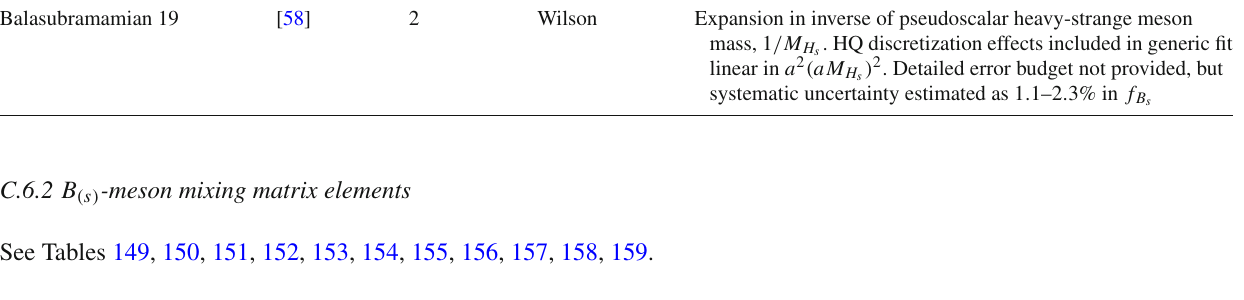
Table 148 Heavy-quark treatment in N f = 2 determinations of the B -and B s -meson decay constants Collab.